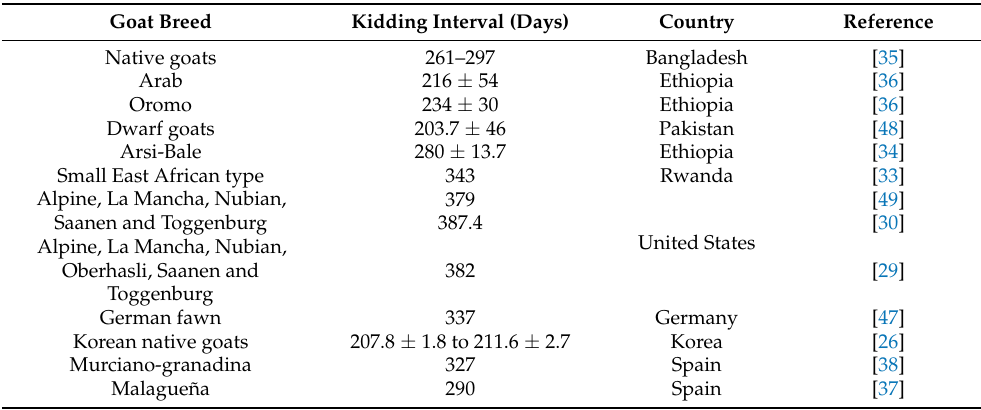
Table 6. Kidding interval data of several local goat